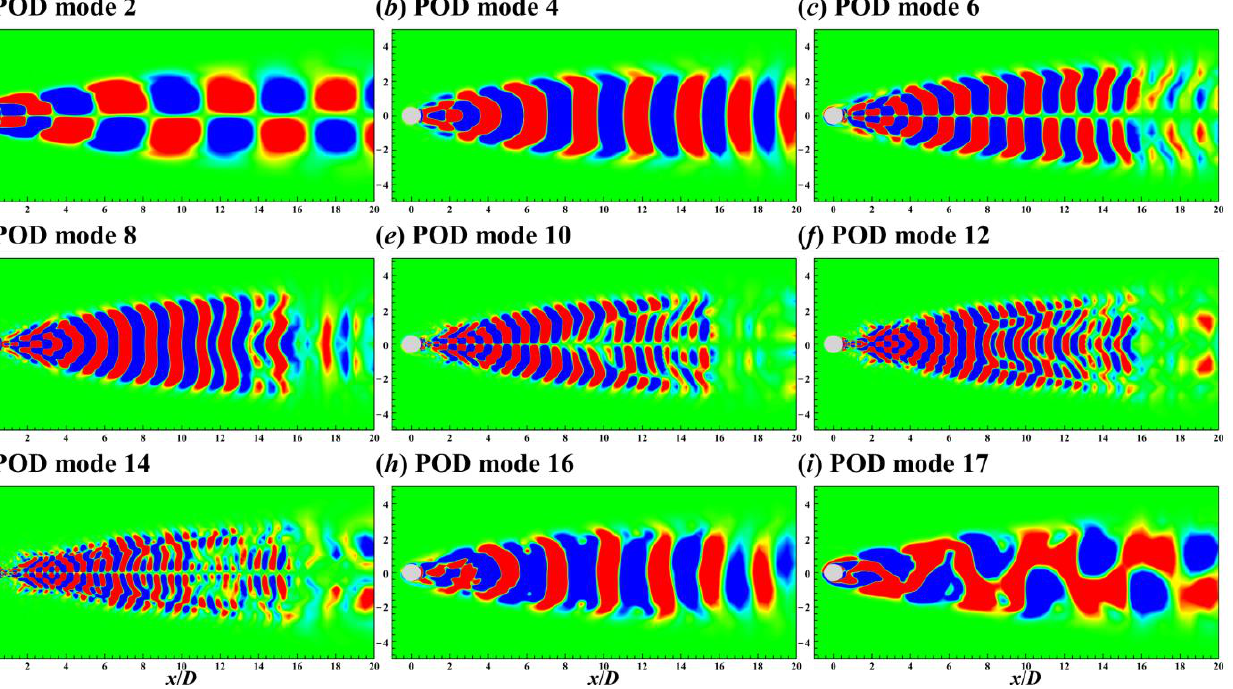
Figure 15. Contours of the 2nd ( a ), 4th ( b ), 6th ( c ), 8th ( d ), 10th ( e ), 12th ( f ), 14th ( g ), 16th ( h ), and 17th ( i ) POD modes on the xz plane for the flow around the single cylinder.